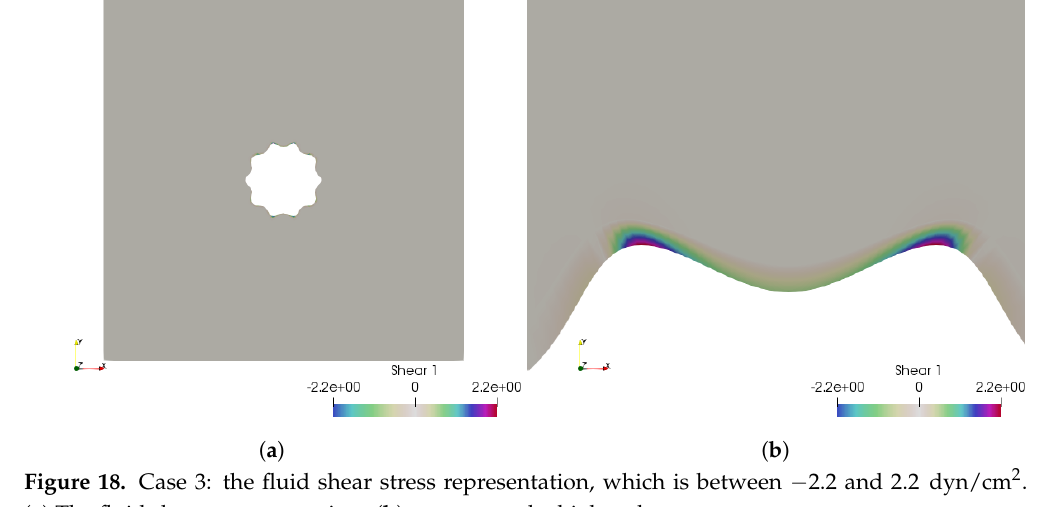
Figure 18. Case 3: the fluid shear stress representation, which is between − 2.2 and 2.2 dyn/cm 2 .